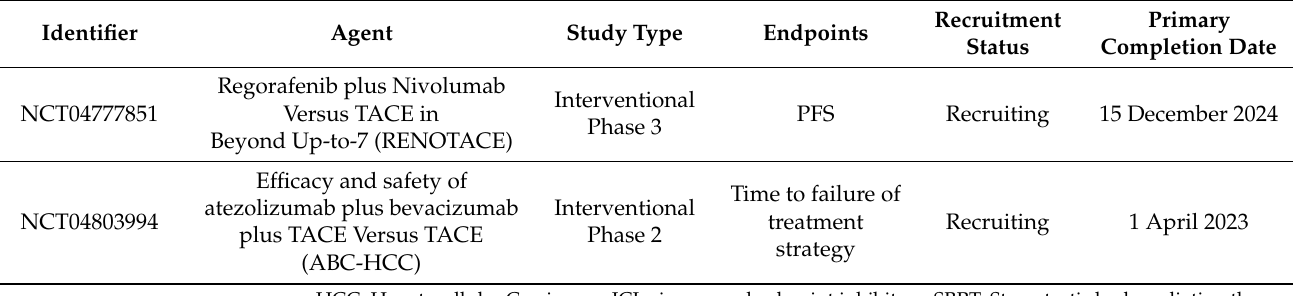
Table 3. Current and ongoing studies of immunotherapy for intermediate